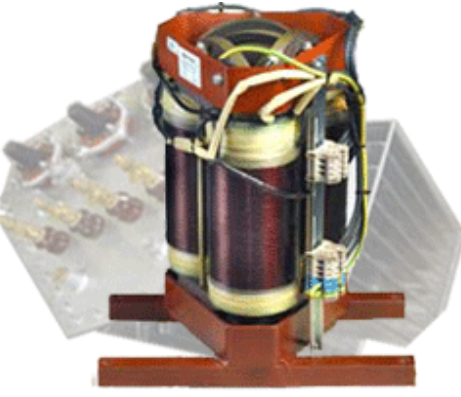
Figure 7. “Design of hexagonal transformer”. Source: